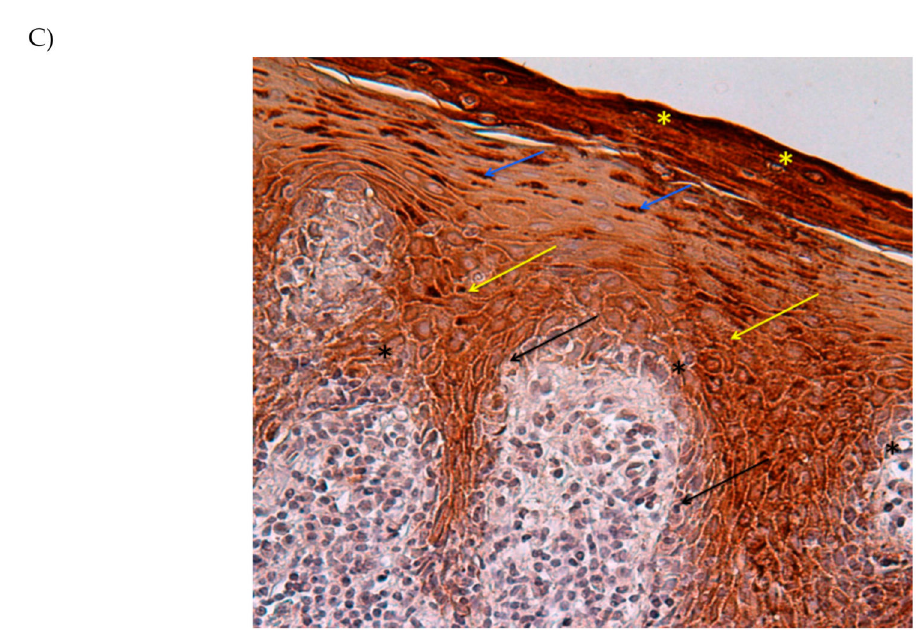
Figure 2. Histological staining with haematoxillin eosin and immunohistochemical analyses against keratin (brown) in control ( a ) and Peri-implantitic (PI) ( b , c ) samples. Black asterisks: cuboid keratinocytes (stratum germinativum), yellow arrows: cells of the upper spinous layers contain lamellar granules, blue arrows: stratum granulosum, yellow asterisks: stratum corneum, black arrows: basal lamina, between epidermis and dermis (100 ×